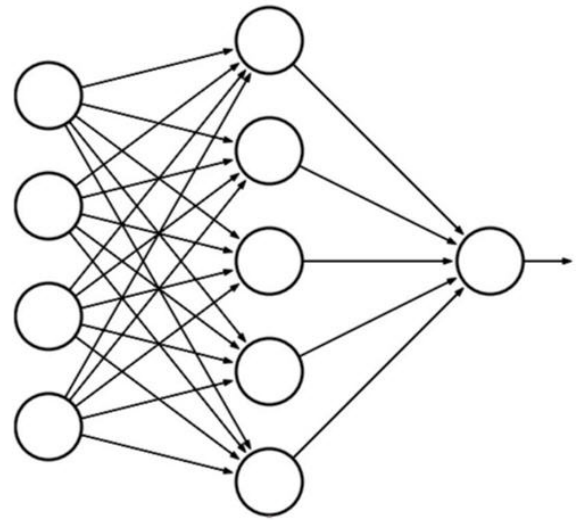
Figure 4. Artificial neural network architecture with tree layers: Input layer, hidden layer, and output layer.